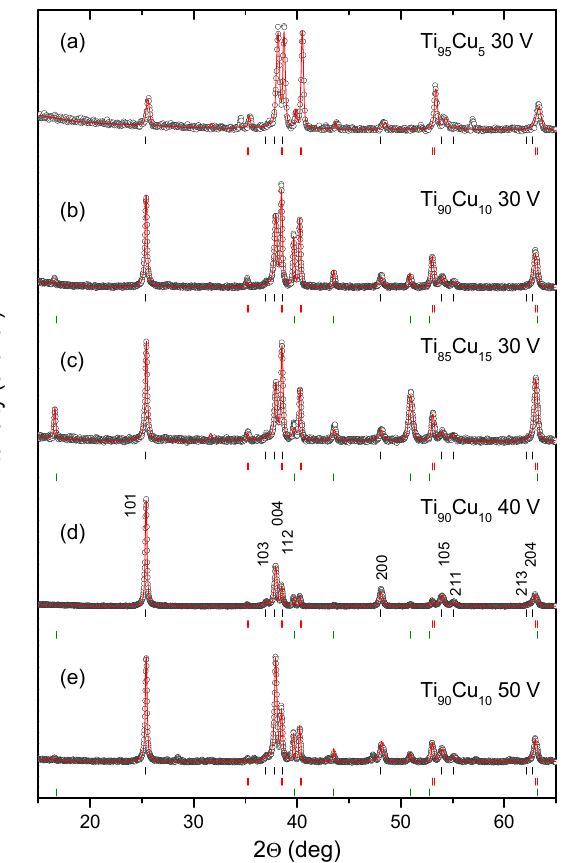
Figure 2. X-ray diffraction patterns for Ti-Cu alloys. A red solid line is a LeBail fit to the experimental data (open circles). Vertical bars represent positions of expected Bragg peaks for (from top): TiO 2 —anatase (black), Ti (red), and CuTi 2 alloy (olive), respectively.